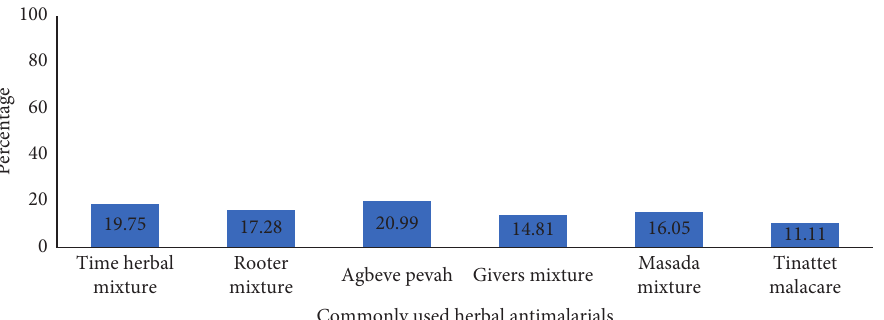
Figure 1: A bar chart showing the most commonly used liquid herbal antimalarials by respondents ( n � 150) living within the Ningo Prampram district. The respondents indicated that Agbeve pevah was the herbal antimalarial drug they frequently used (20.99%), while Tinattet malacare was the least (11.11%) herbal antimalarial drug they used.